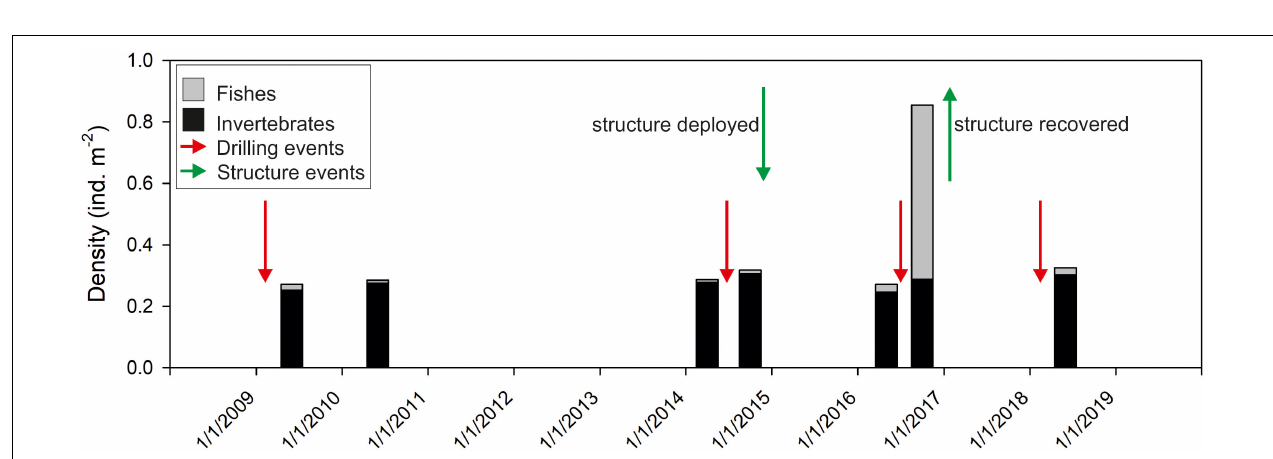
FIGURE 6 | Time series observations of mean abundance of megafaunal invertebrates and fishes in video transects around wells in the Lancaster field. Green arrows indicate deployment and recovery of Structure A. Red arrows indicate drilling